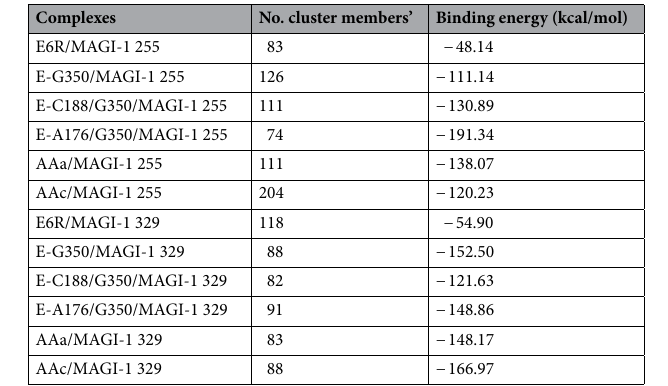
Table 1. Docking binding affinity of E6 HPV-16 and its